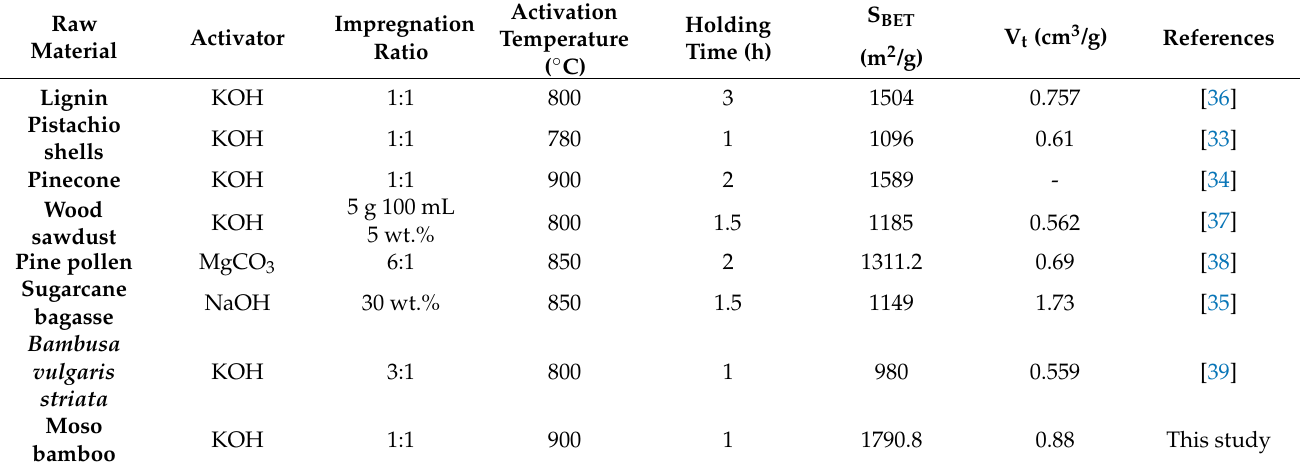
Table 3. Comparison of pore texture characteristics and S BET of activated